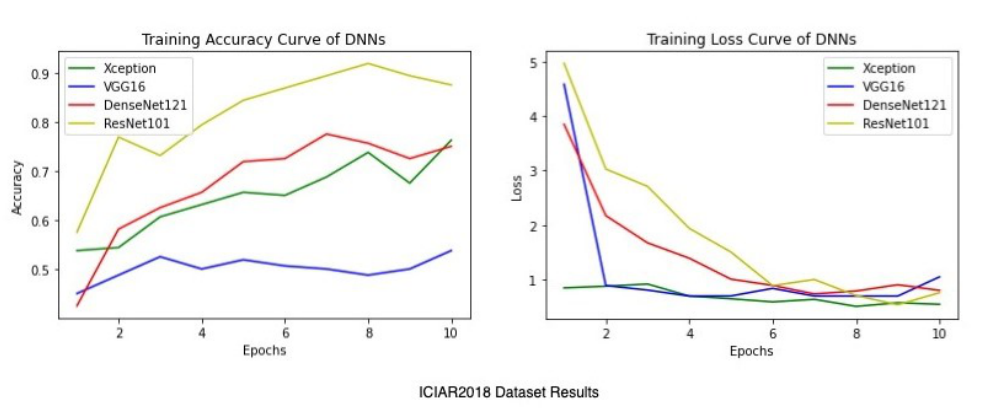
Figure 12. Average training accuracy and loss of 5 folds for the ICIAR2018 dataset.